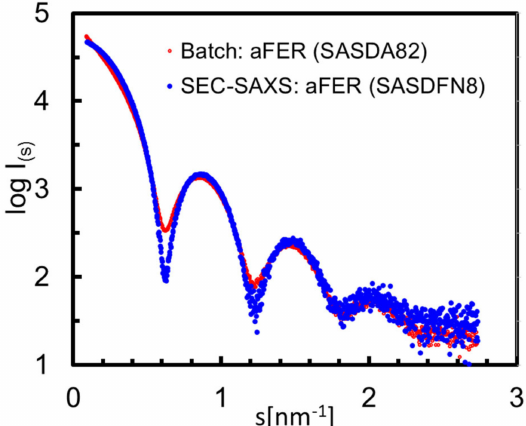
Figure 7. Comparison of SAXS data collected in Batch mode with the SEC-SAXS data described here. The SASBDB entries are